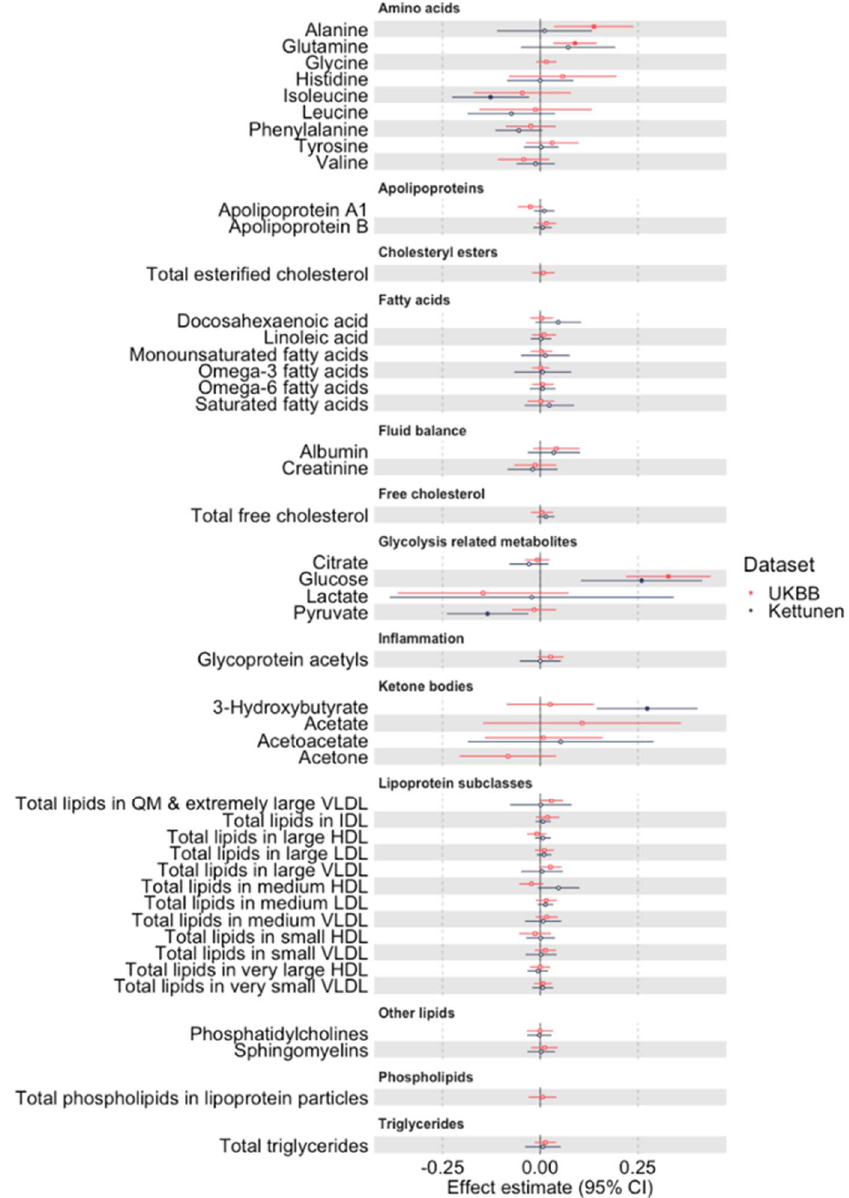
Figure 1. UVMR effect estimates, with 95% confidence interval (CI), for the relation of maternal metabolic traits with offspring birthweight using SNPs selected from UKBB and Kettunen GWAS. Effect estimates (with 95% CI) are expressed as standard deviation (SD) units of offspring birthweight per SD unit change in metabolic trait using the Wald ratio (no. SNPs = 1) or IVW (no. SNPs > 1). The number of SNPs selected from UKBB and Kettunen GWAS for each metabolic trait is available in Table S2. Solid circles identify the metabolic traits that were taken forward to MVMR on the basis of having some evidence for statistical association with birthweight in UVMR ( p < 0.05). CI: confidence interval, GWAS: genome-wide association study, MVMR: multivariable Mendelian randomisation, SNP: single-nucleotide polymorphism, UKBB: UK Biobank, UVMR: univariable Mendelian randomisation.